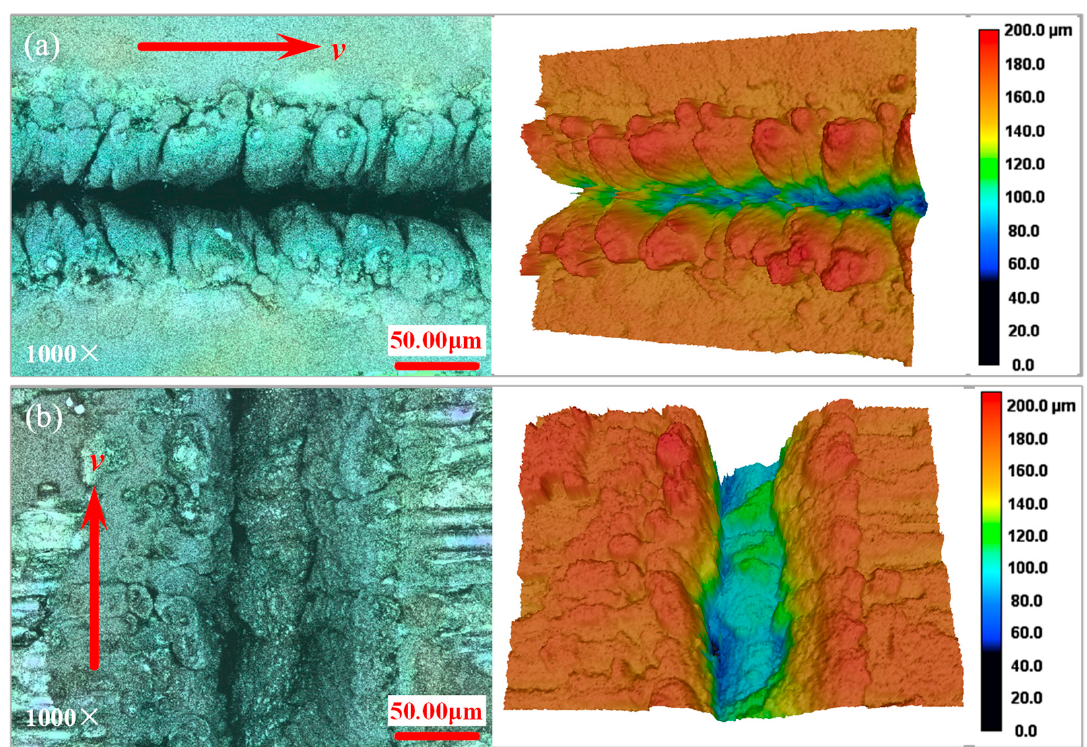
Figure 6. The grooved morphologies in different scanning directions under laser power of 14 W and repetition frequency of 12 kHz. ( a ) Transverse scanning region; ( b ) longitudinal scanning region.